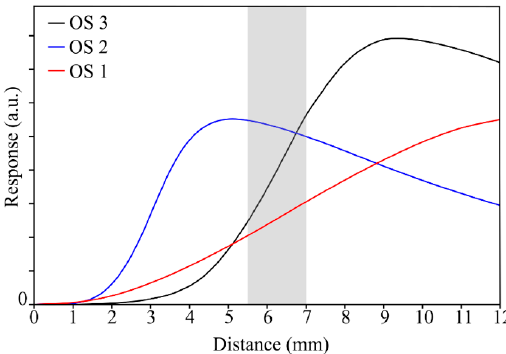
Figure 4. Calibration curve of each sensor. The shaded region shows the working region of interest.